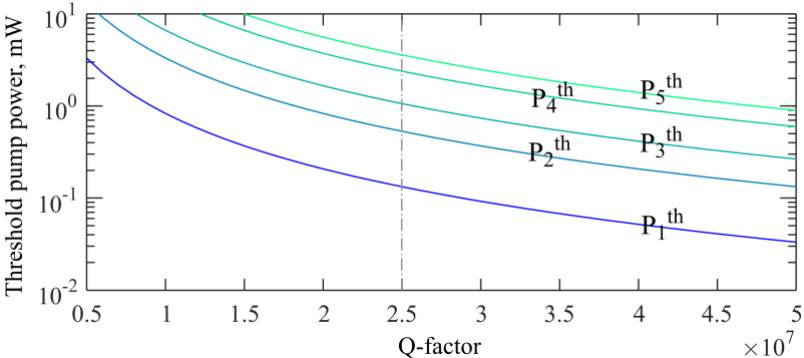
Figure 11. Theoretically calculated threshold pump powers as functions of Q-factors for cascade Brillouin waves of the 1st – 5th orders for zero detuning (Δω 0 = 0). Thresholds for waves of the 6th and higher orders are not shown.